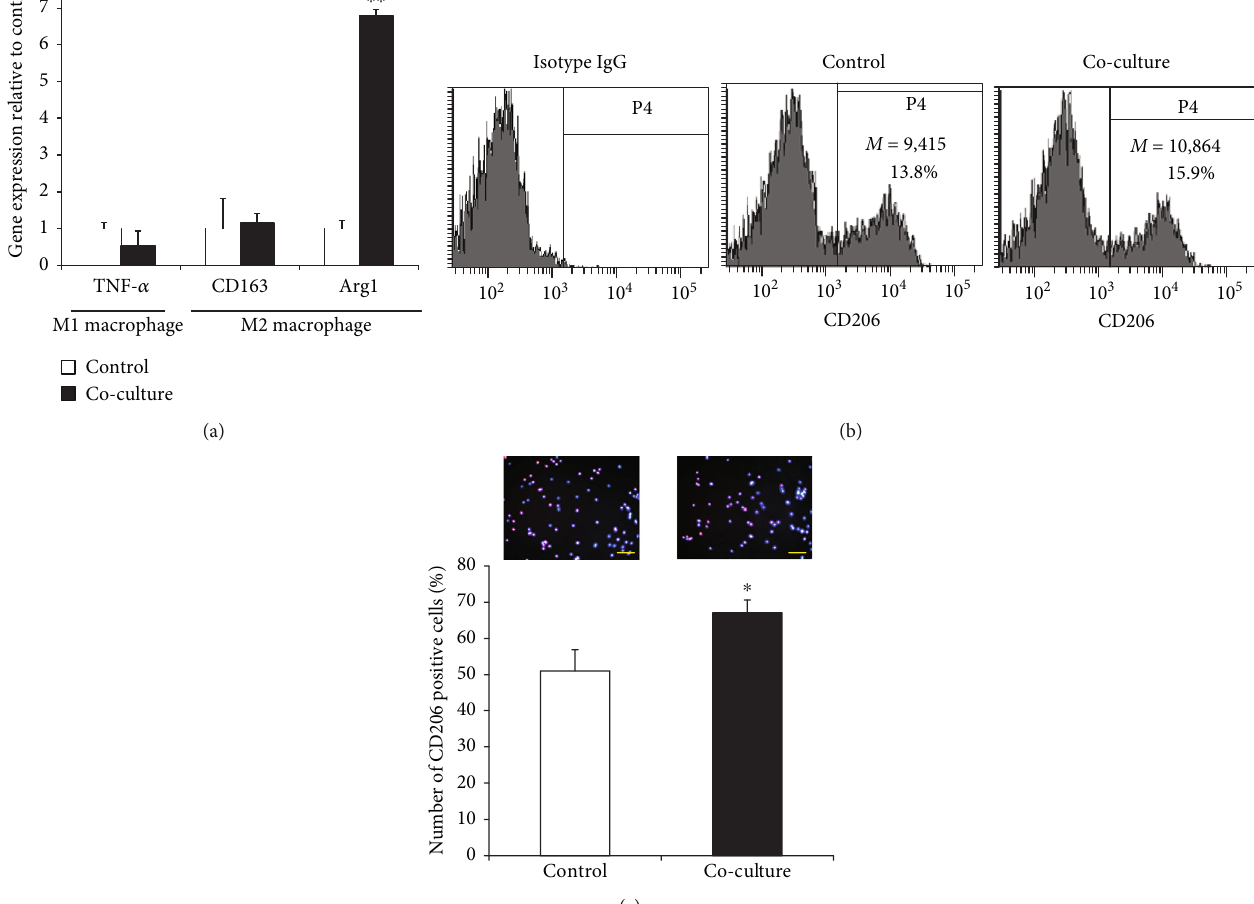
Figure 1: AdMSCs induce macrophage M2 polarization. (a) qPCR analysis of coculture of AdMSCs with PBMCs for 24h revealed increased gene expression of Arg1 (M2 macrophage marker). (b) Expression of CD206 in PBMCs after coculture as assessed by fl ow cytometry. (c) PBMCs were cocultured with AdMSCs for 24 h, then stained with CD206 (M2 macrophage marker) antibody by immuno fl uorescent staining ( scale bar = 100 μ m ). The percentage of CD206-positive cells was determined by counting the number of stained cells. The data are expressed as the mean ± SD of three independent experiments. ∗ P < 0 : 05 , ∗∗ P < 0 : 01